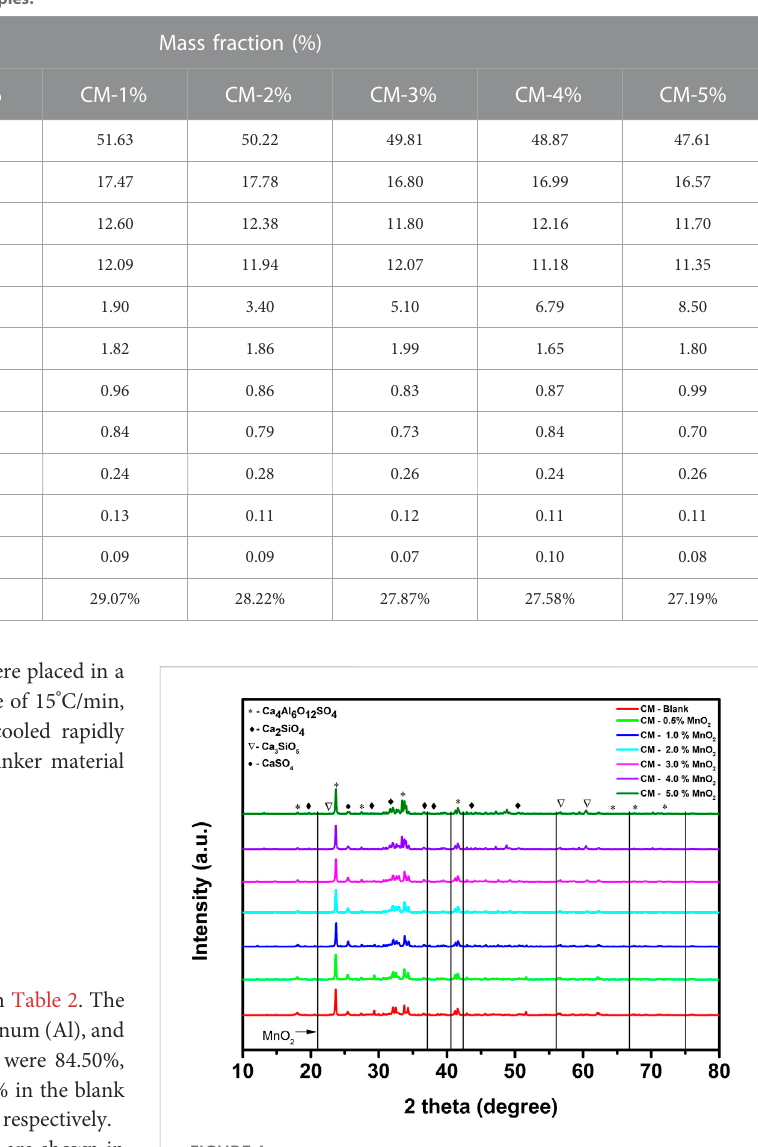
FIGURE 1 The XRD patterns of Mn doped clinker samples (red: CM-blank, green: CM-0.5% MnO 2 , blue: CM-1% MnO 2 , cyan: CM-2% MnO 2 , magenta: CM-3% MnO 2 , violet: CM-4% MnO 2 , olive: CM-5% MnO 2 , black: reference diffraction pattern of MnO 2